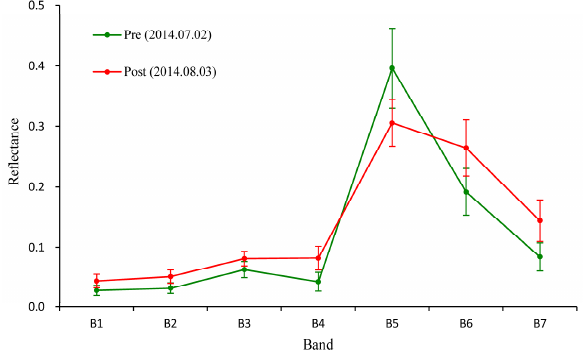
Figure 5. The characteristics of different bands of Landsat-8 pre- and post-typhoon for the affected forest sampling area (Error bars represent positive and negative one standard deviation)